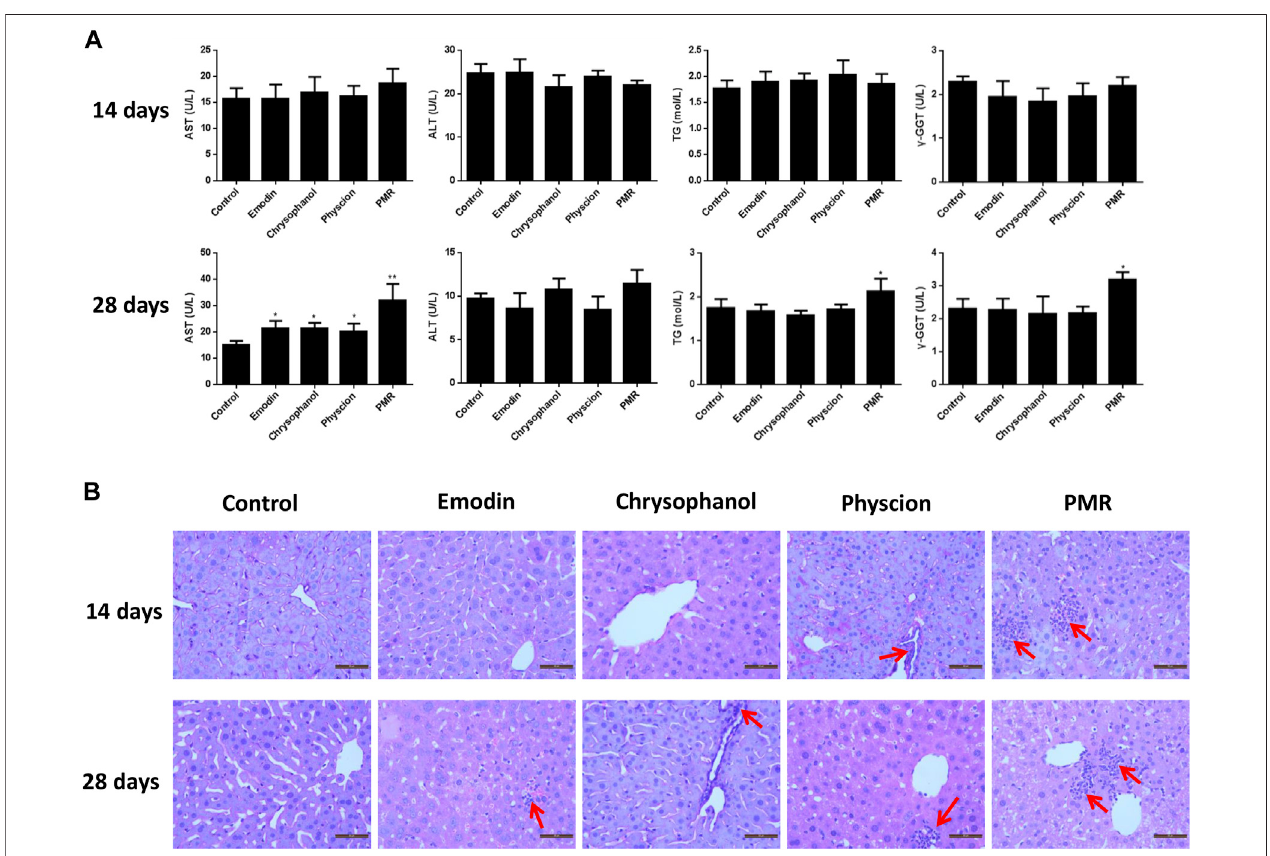
FIGURE 1 | Serum levels of AST, ALT, TG, and γ -GGT (A) and typical liver histopathological section photos ( (B) Hematoxylin and eosin stained, original magni fi cation ×400) in different groups of mice following 14- or 28-day treatment with anthraquinones or PMR extract. In fl ammatory cell in fi ltration was indicated by the solid arrow. Data were presented as mean ± SD (n = 8). * p < 0.05, ** p < 0.01 compared with control